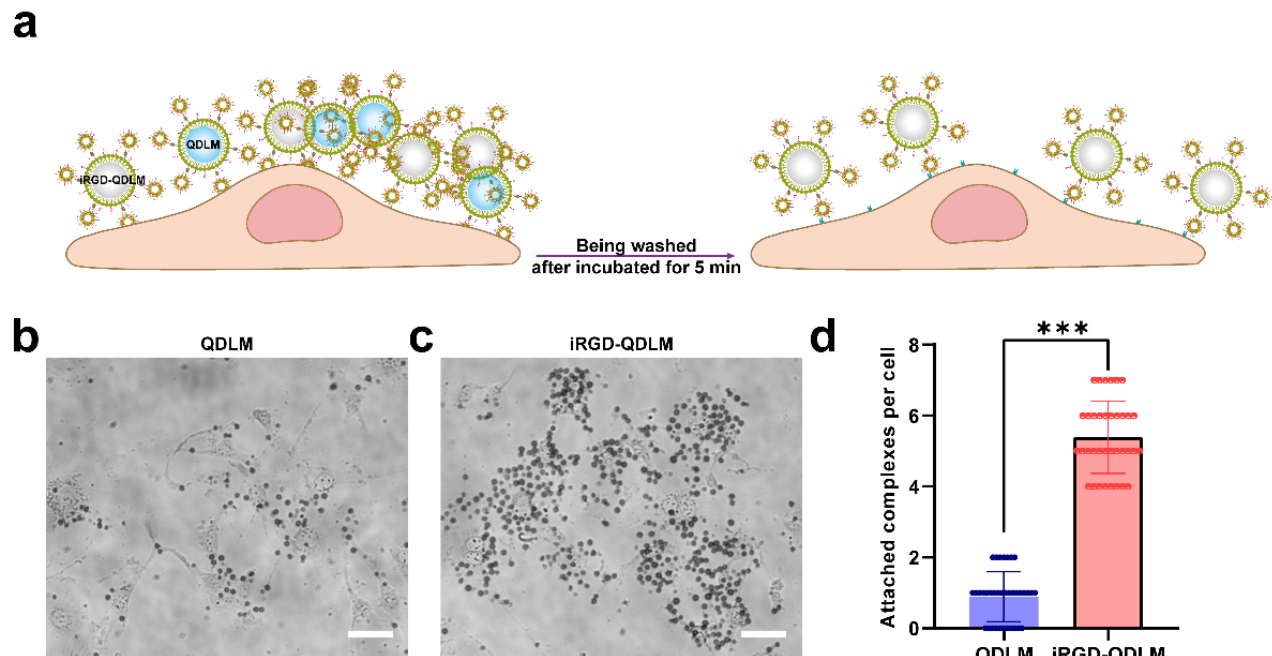
Figure 3. Binding specificity of iRGD-QDLM. ( a ) Schematic diagram of iRGD-QDLM attached to the surface of 4T1 breast cancer cells. ( b ) Representative bright field imaging of QDLM and iRGD-QDLM ( c ) attached to 4T1 breast cancer cells. Scale bar: 50 µ m. ( d ) Quantitative analysis of the number of attached complexes per cell. *** p < 0.001.